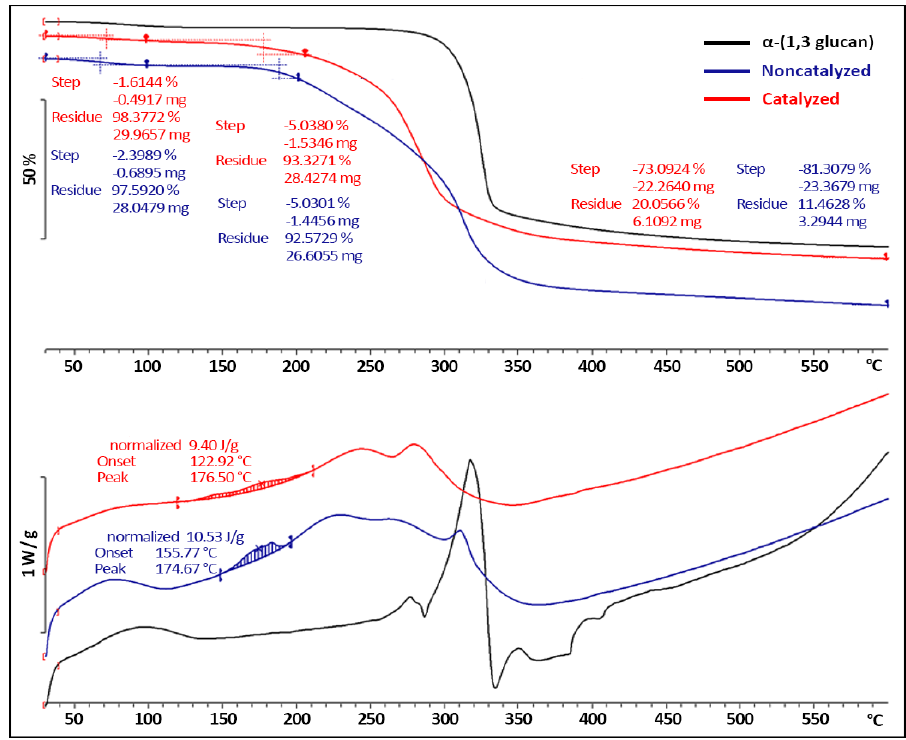
Figure 6. Coupled TGA/DSC runs on products derived from the modification of α -(1,3) glucan with SA in laboratory scale.